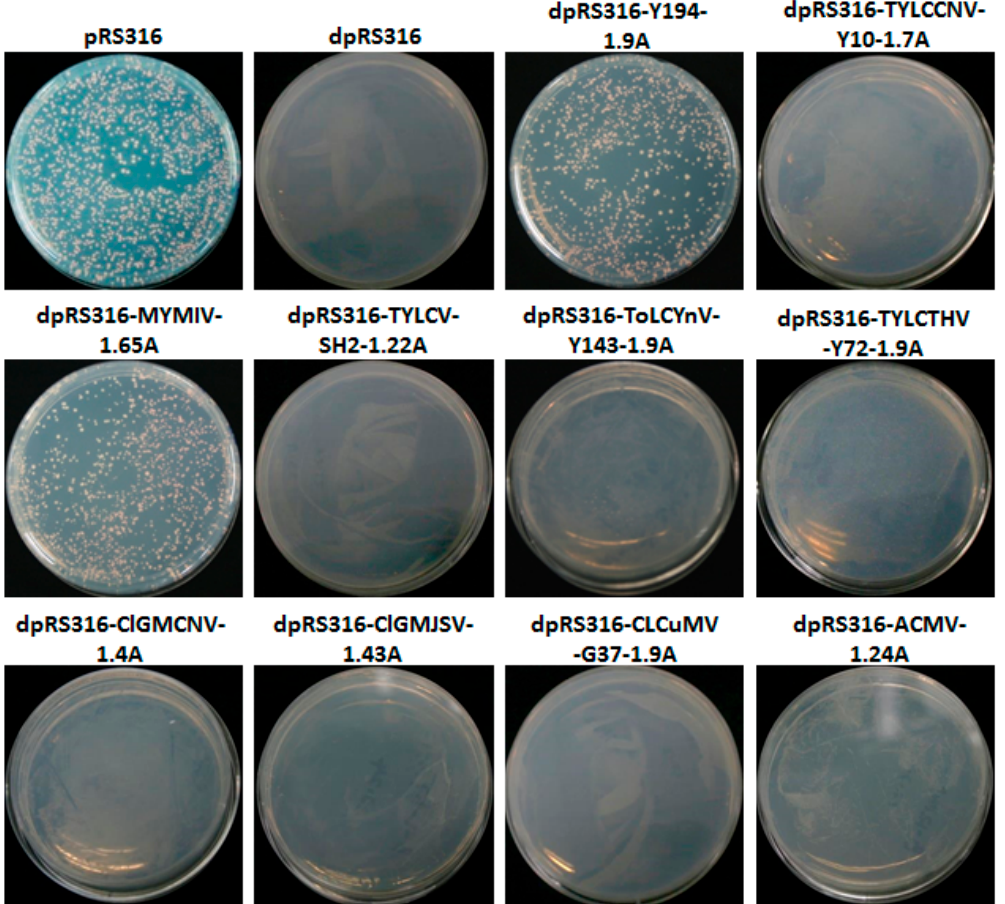
Figure 1. Screening of geminivirus replication using a deficient yeast plasmid in yeast cells. Saccharomyces cerevisiae W303-1B cells were transformed with pRS316 (the positive control plasmid), dpRS316 (the negative control plasmid), dpRS316-Y194-1.9A, dpRS316-TYLCCNV-Y10-1.7A, dpRS316-MYMIV-1.65A, dpRS316-TYLCV-SH2-1.22A, dpRS316-ToLCYnV-Y143-1.9A, dpRS316-TYLCTHV-Y72A-1.9A, dpRS316-CLGMCNV-1.4A, dpRS316-CLGMJSV-1.43A, dpRS316-CLCuMV-G37-1.9A, or dpRS316-ACMV-1.24A. Photographs were taken at 4 days (d) post transformation.